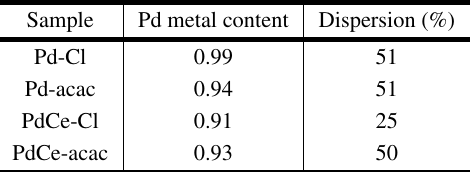
Metal contents and